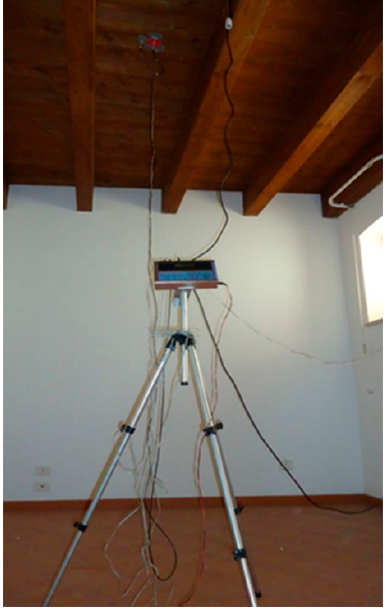
Figure 7. Onsite set-up for heat flow meter method: measurement probes on the intrados of the timber structure.